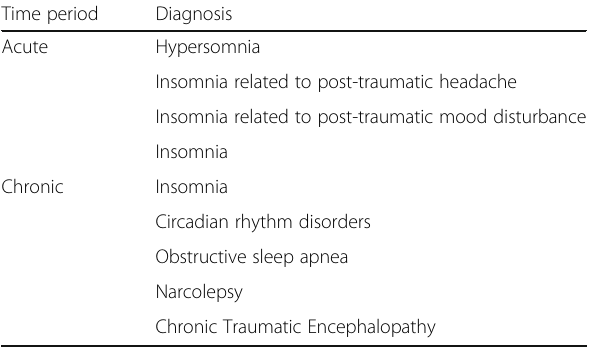
Table 1 Sleep Disturbances Following TBI in the Acute